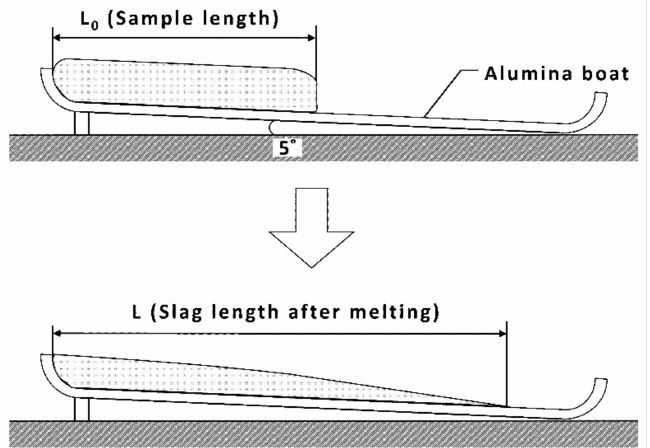
Figure 4. Schematic of pouring index experiment method [16].